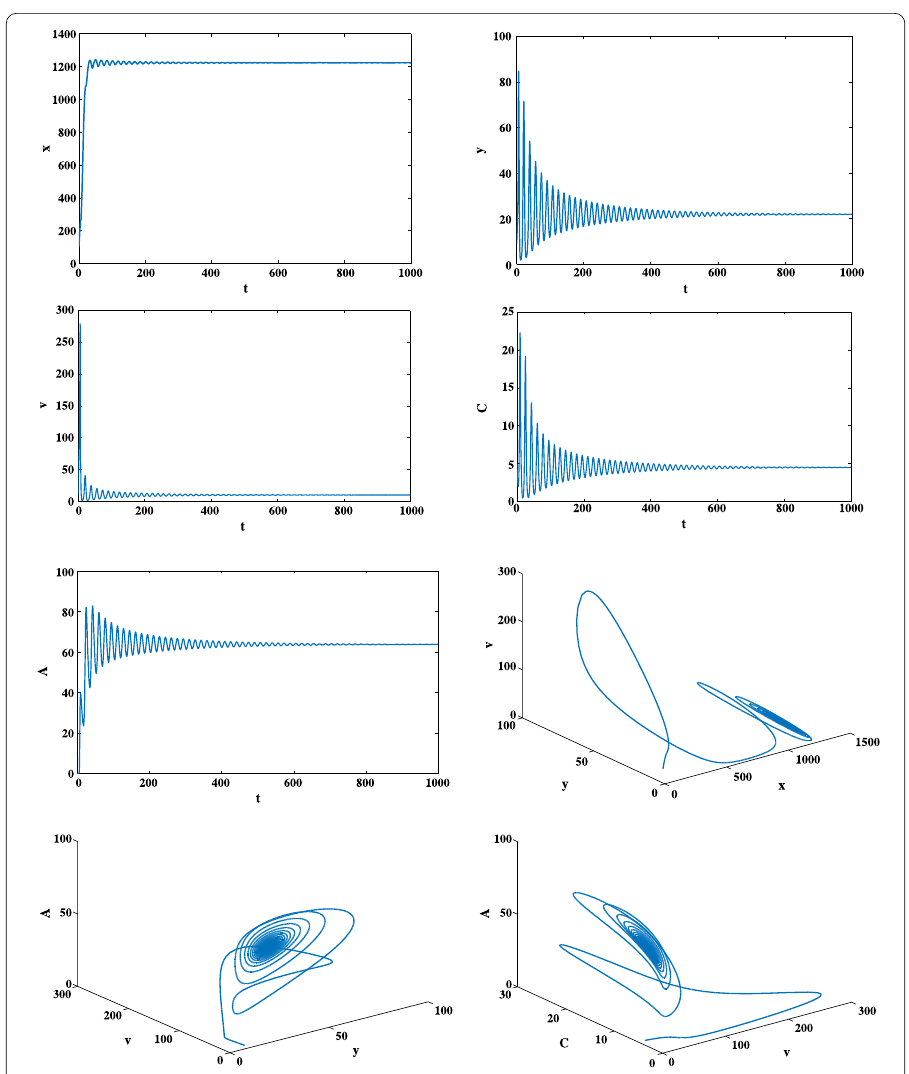
Figure 1 The phase diagrams of system (2) being asymptotically stable when τ =